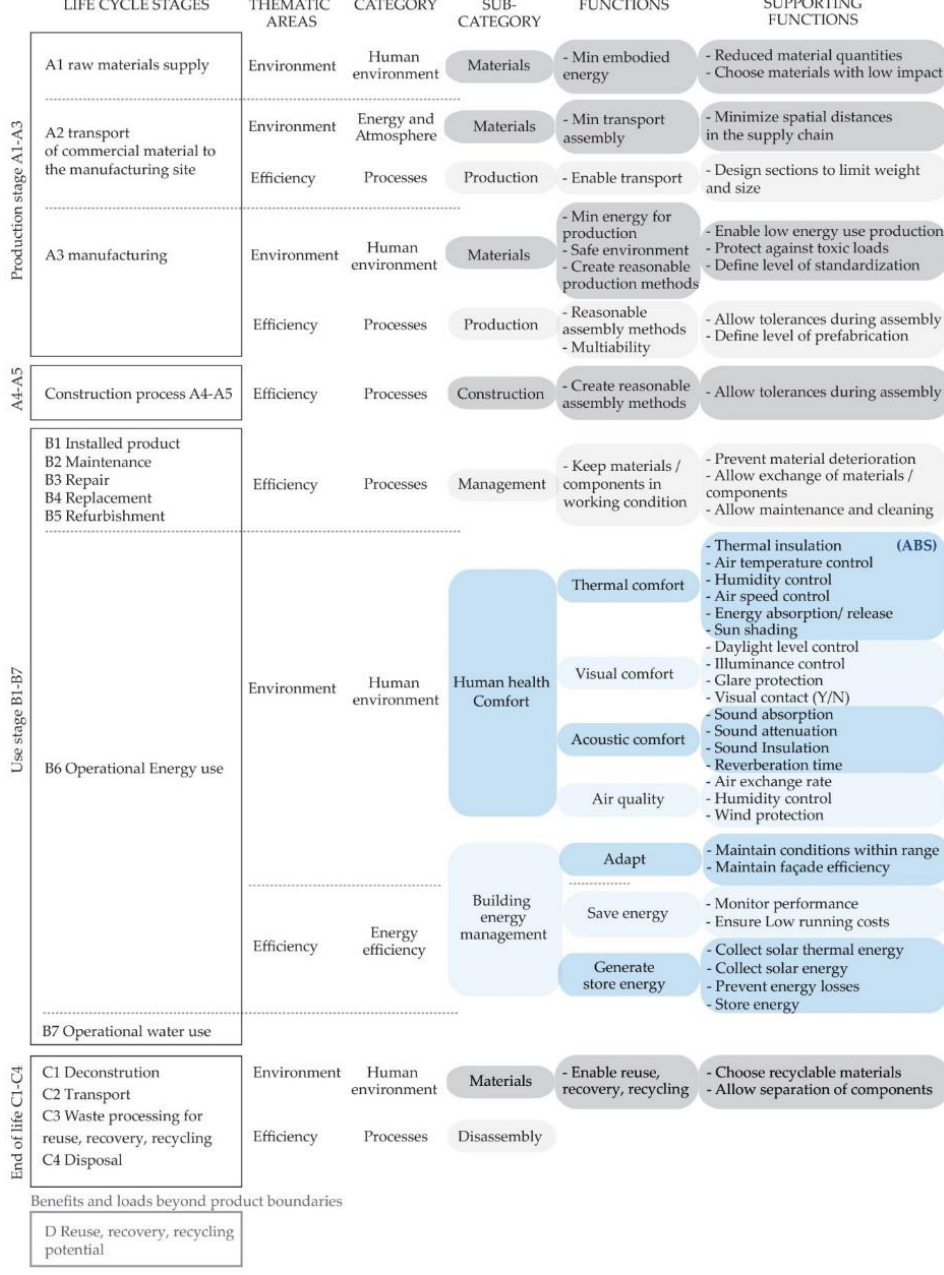
Figure 5. Sustainable categories and functions related to Adaptive Building Technologies (ABT) life cycle (focus on Adaptive Building Skins (ABS) in the usage stage B6).